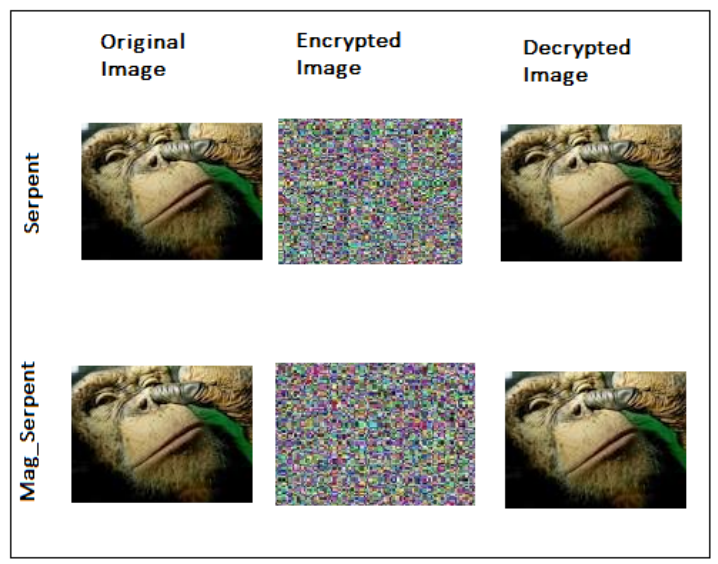
Figure 18. Encryption and decryption of image by using Serpent and